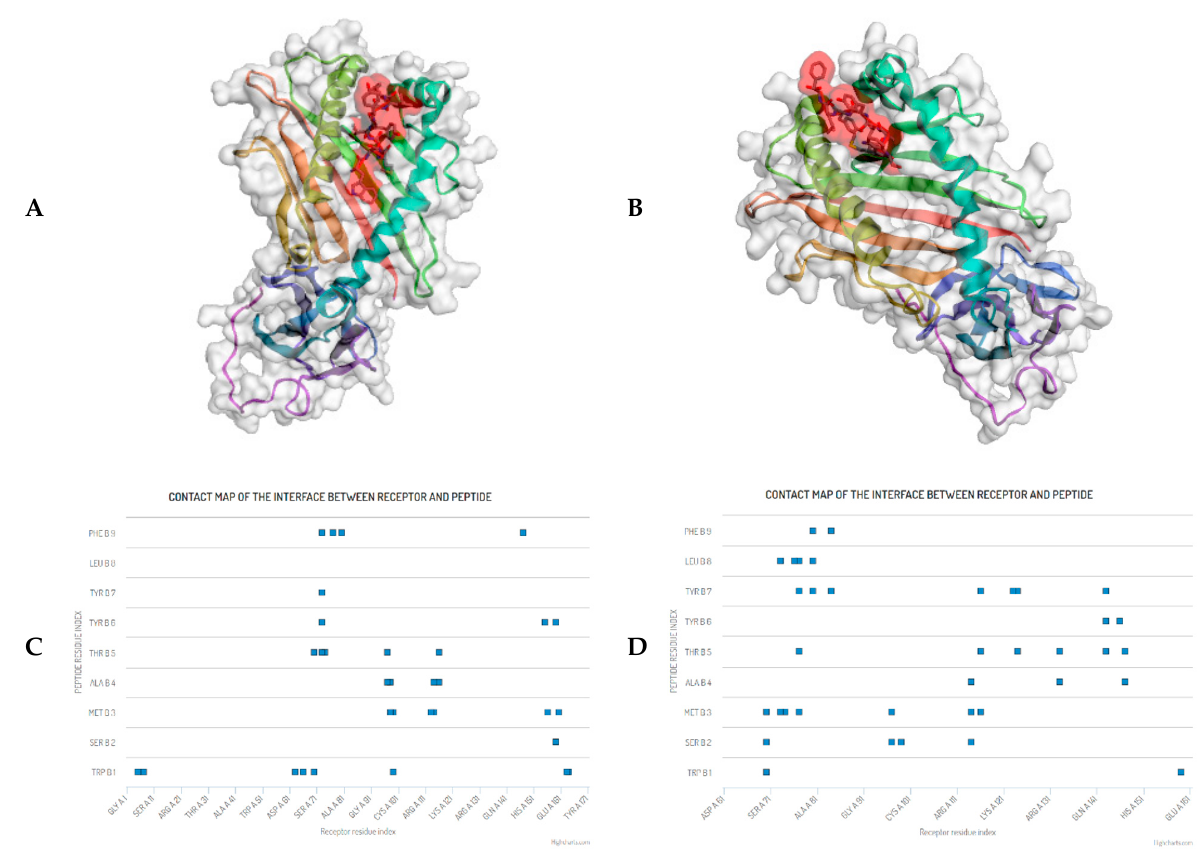
Figure 10. The best CABS-dock Modeling with default settings for peptide WSMATYYLF (stick structure in red color) with HLA-A*24:07 ( A ) and HLA-A*24:02 ( B ). The contact map between peptide and receptor for HLA-A*24:02 ( C ) and HLA-A*24:07 ( D ). CABS-dock server returns 10 top scored models of the protein-peptide complex. The best model prediction had high accuracy with average RMSD of 0.94 Å and 1.64 Å for HLA-A*24:07 and HLA-A*24:02, respectively. Moreover, the best model also had the highest cluster density score. HLA-A*24:07–WSMATYYLF complex had a higher accuracy compare to the HLA-A*24:02–WSMATYYLF complex.